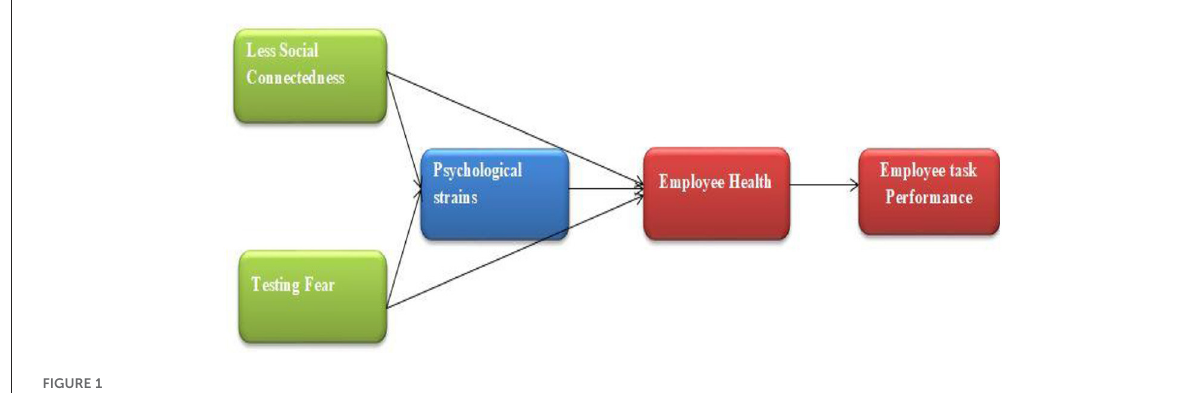
FIGURE1 Conceptual framework.